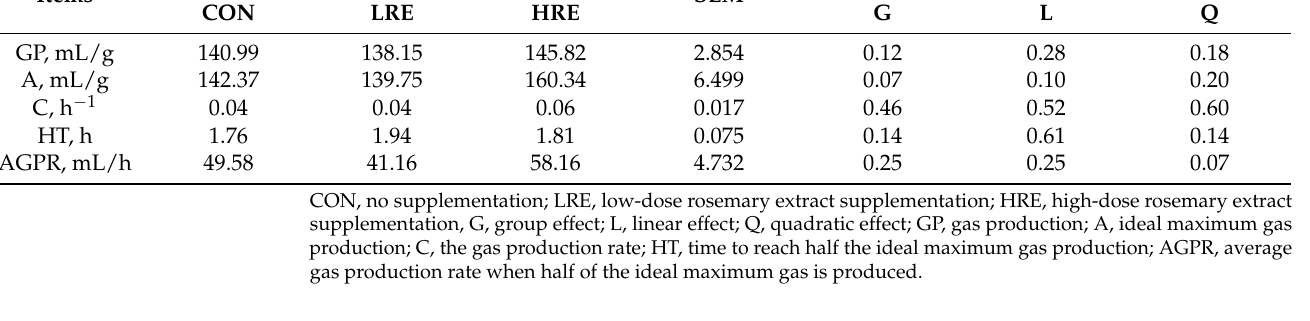
Table 2. Effects of different doses of rosemary extract on gas production of in vitro fermentation.